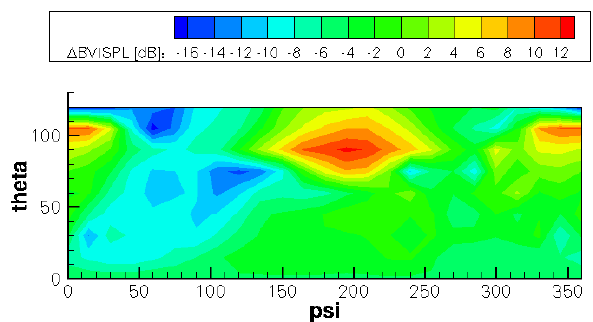
Figure 22: Technique A – C differential BVISPL at point 1 in maneu- ver